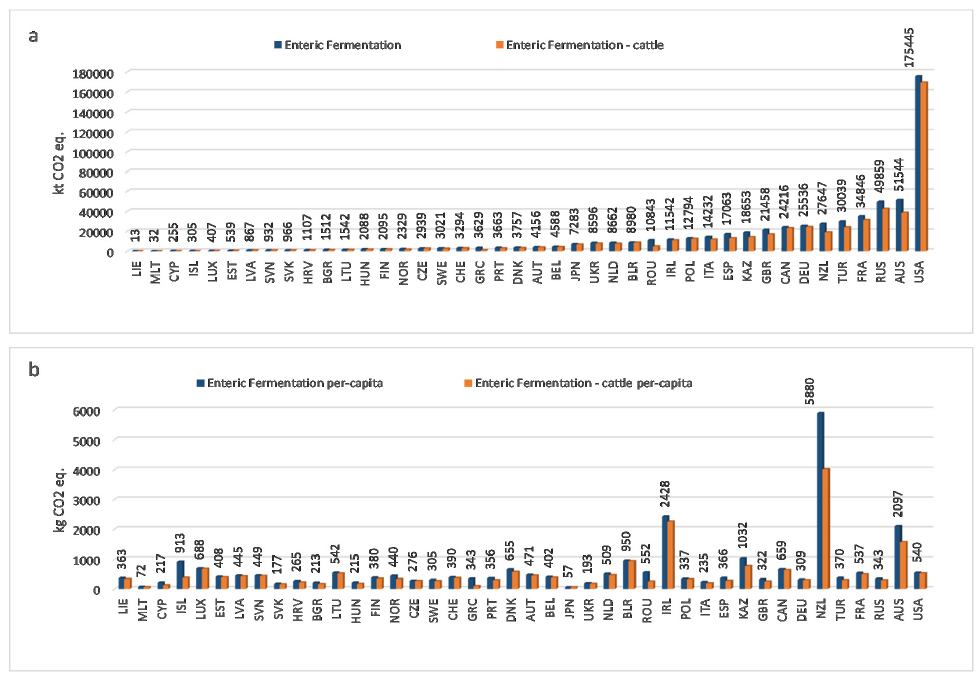
Figure 3. The enteric methane emissions ( a ), and the methane emissions per capita ( b ) from enteric fermentation from all domesticated animals and cattle in each Annex I country for 2017. Numbers indicate the amount of methane emission in kt CO 2 equivalent in each country ( a ), and the amount of methane emission per capita in kg CO 2 equivalent in each country ( b ).